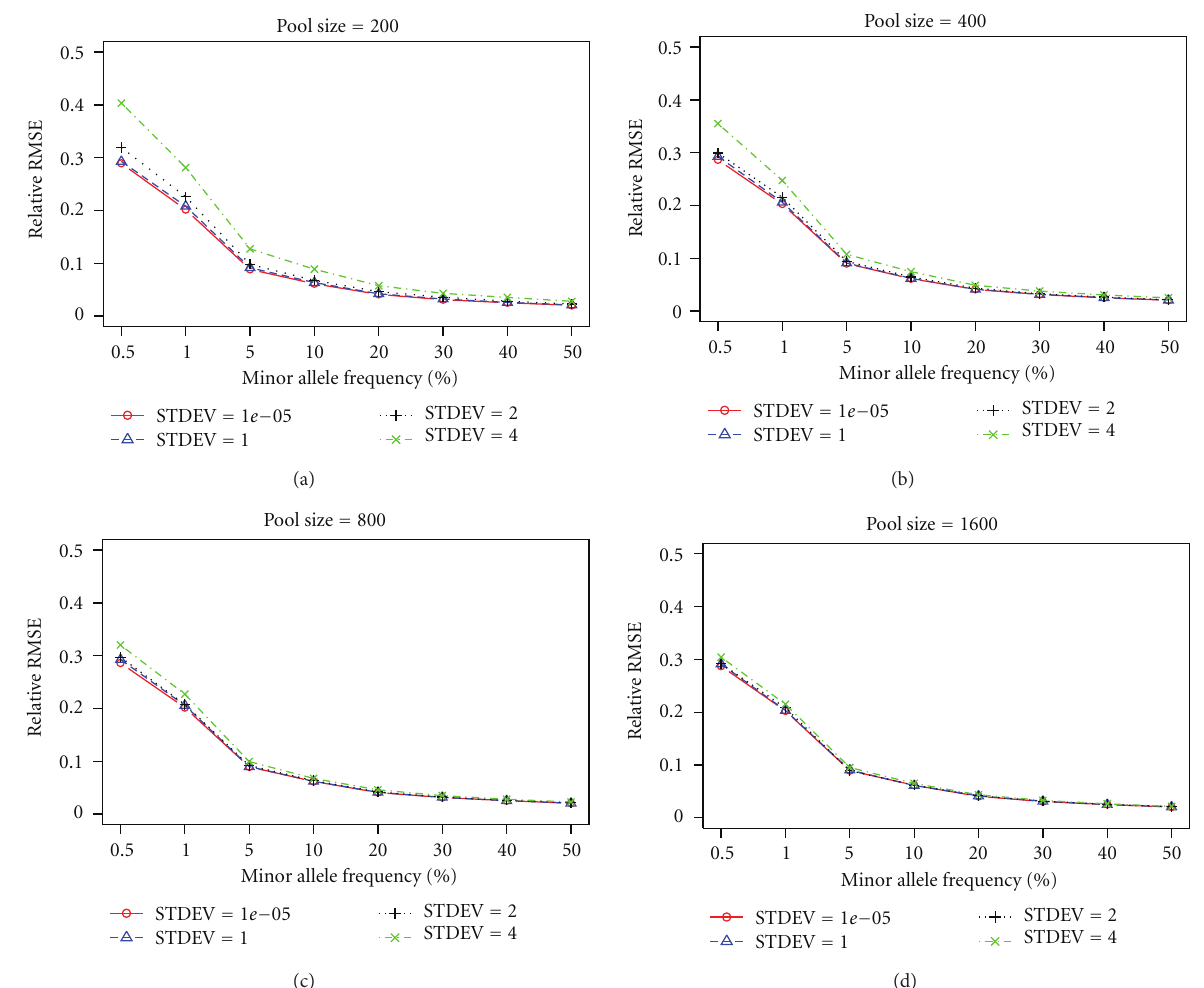
Figure 1: Relative RMSE for different pool sizes and MAFs under different standard